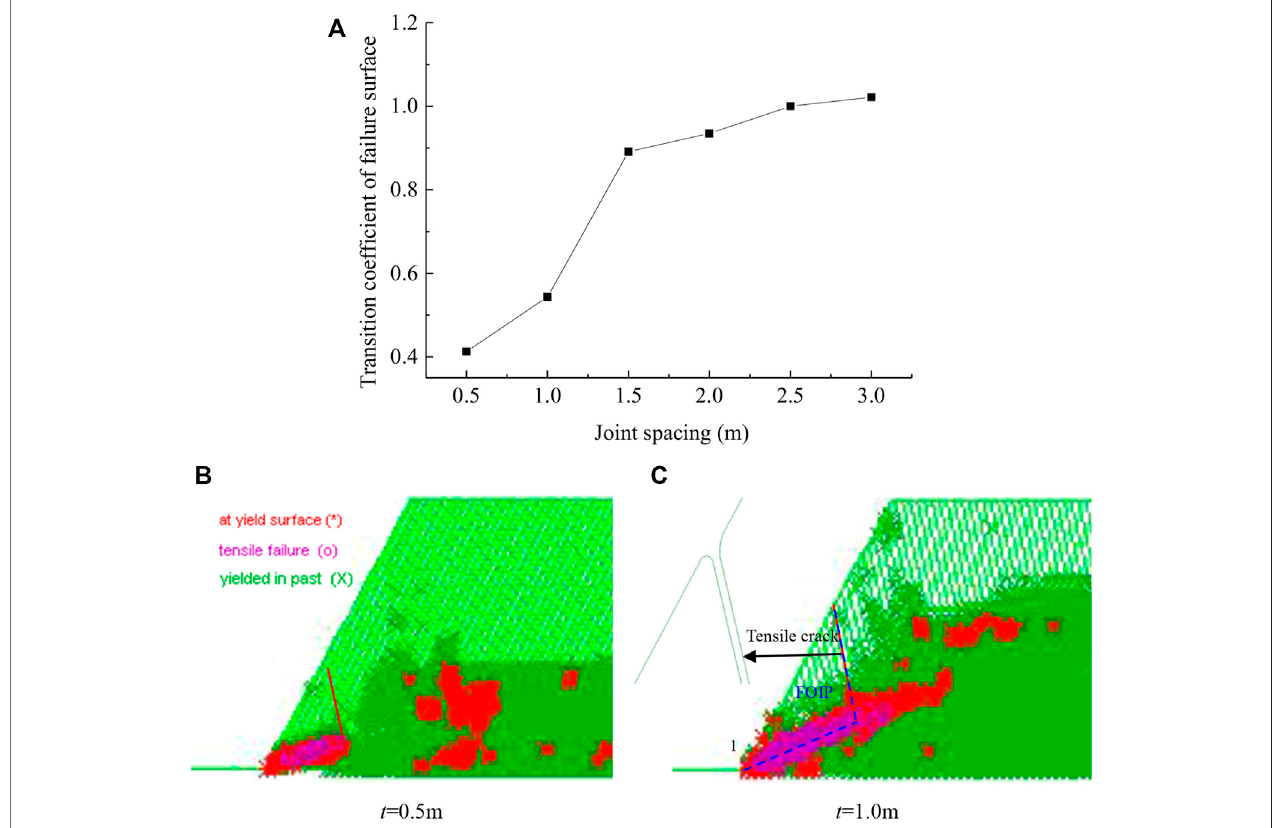
FIGURE 8 | Failure distribution of the slope for different joint spacing ( t ). (A) : Relationship between the transition coef fi cient of failure surface and the joint spacing; (B,C) : The simulated plastic zone obtained using UDEC for different joint spacing.